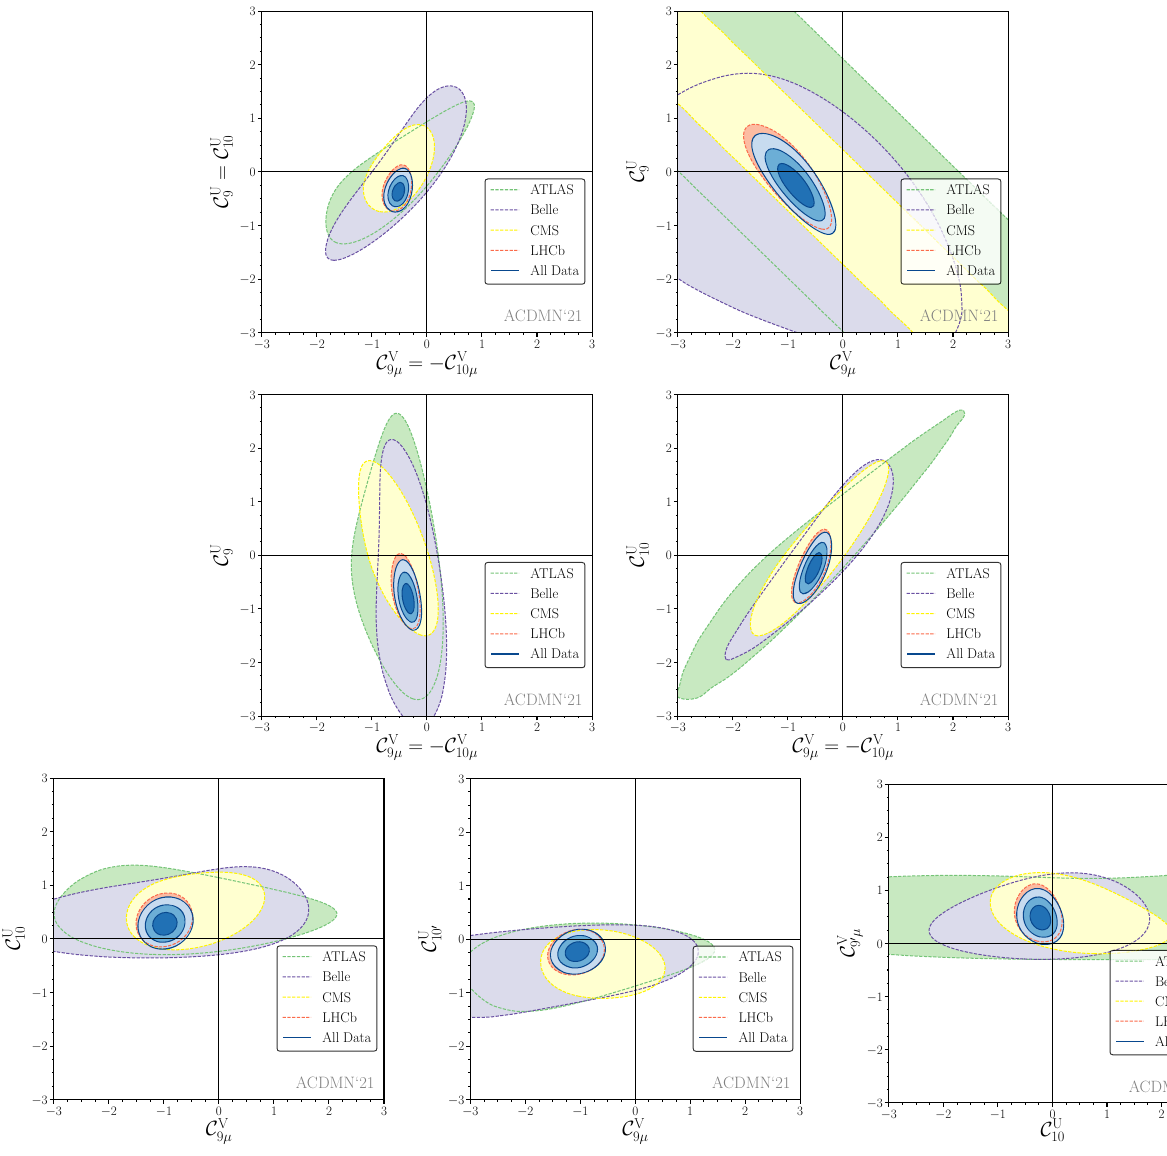
Fig. 2 From left to right : Allowed regions for the 2D scenarios presented in Table 4. Scenarios 6 and 7 on the upper row, 8 and 9 in the middle row and 10–12 in the bottom row using all available data (fit “All”). Dashed lines represent the 3 σ regions while the solid lines represent 1, 2 and 3 σ